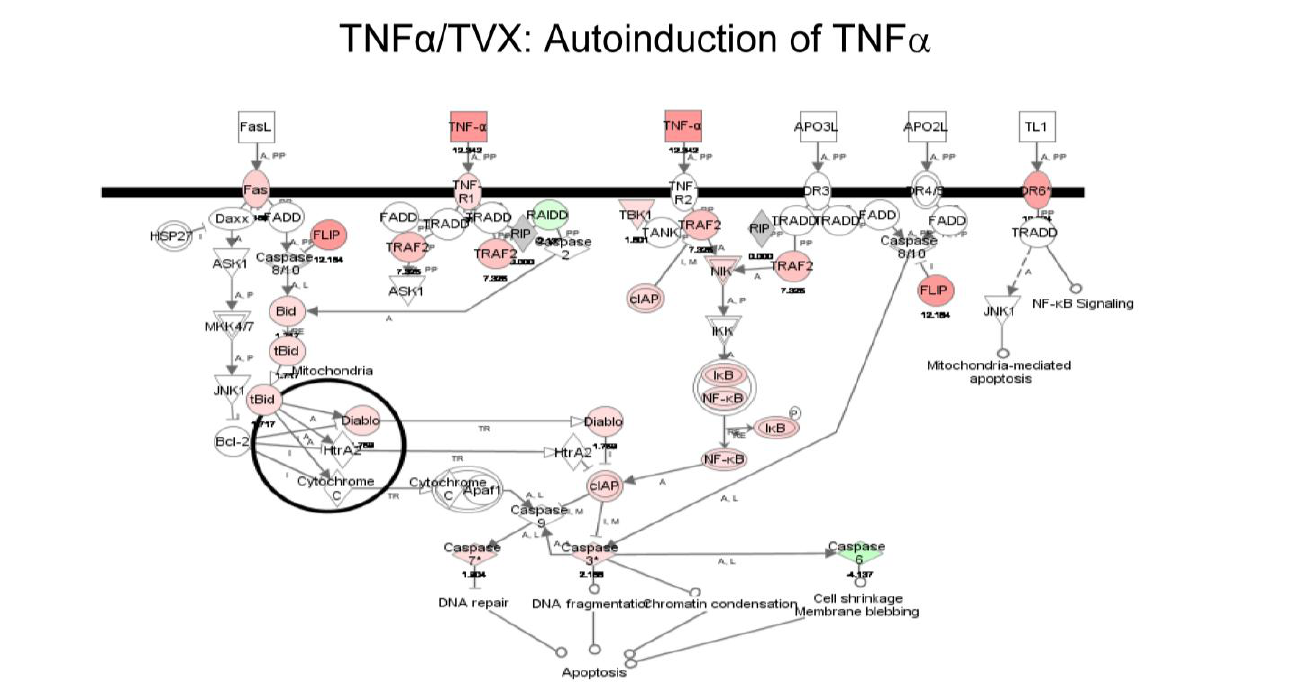
Figure 6. Effect of TNFα autoinduction on the expression of members downstream from TNFα signal transduction. Pathway diagram was generated using Ingenuity software. Each pathway member labeled in red or green represents upregulation or downregulation, respectively. White represents no significant change in expression. TNFα/TVX showed a large degree of downstream activation in contrast to TNFα/LVX (data not